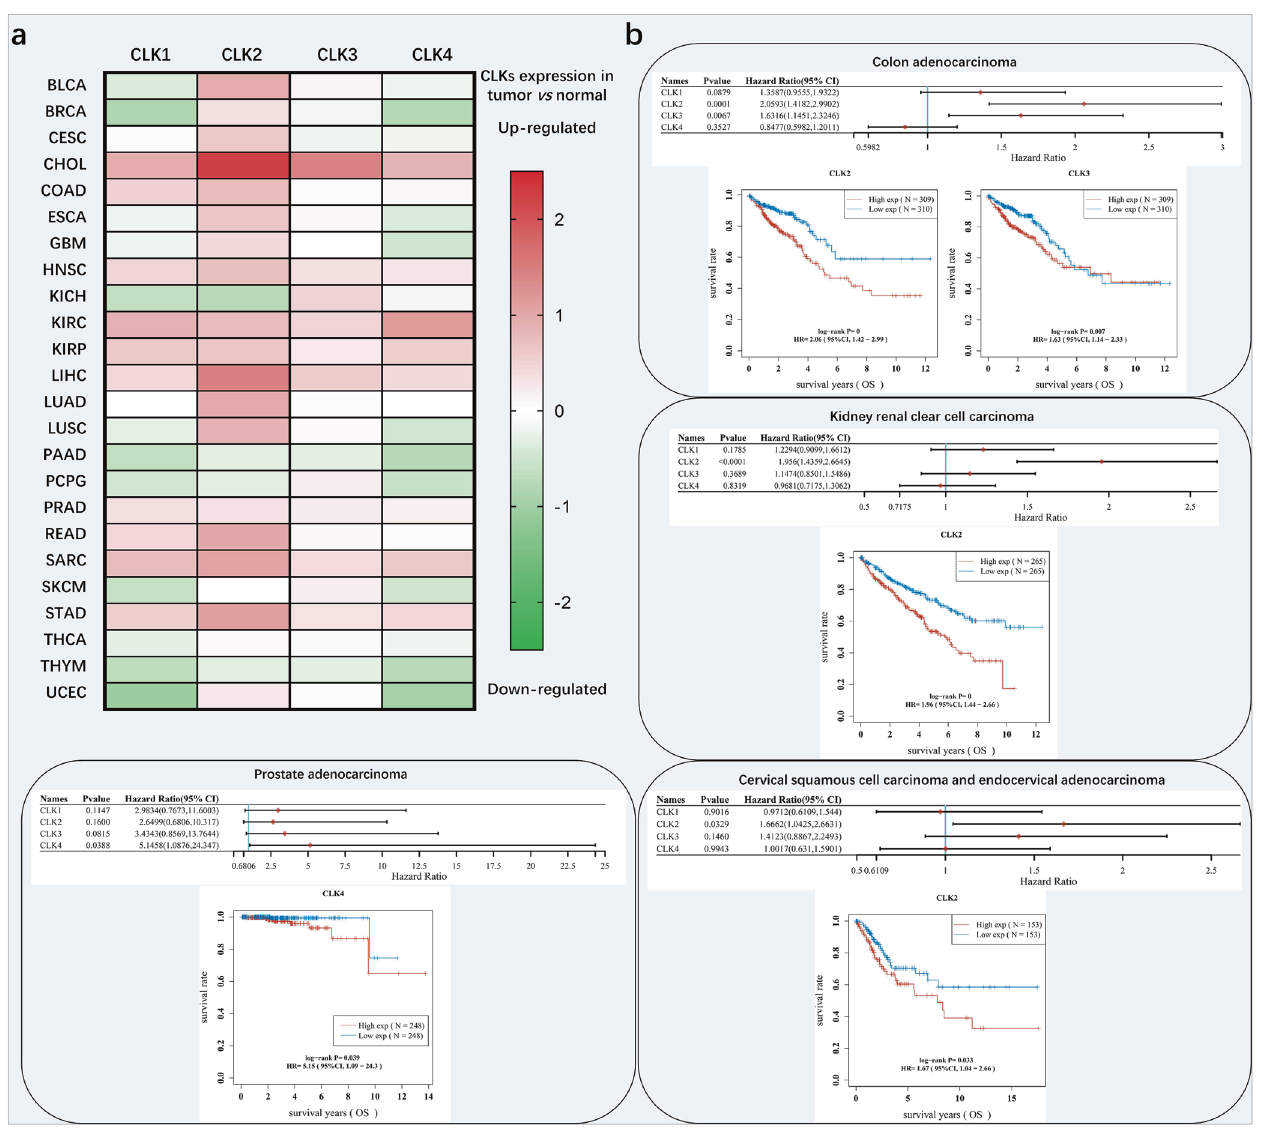
Fig. 5 Expression status and clinical outcomes associated with CLKs transcript levels in different tumor types. a RNA-seq data of CLKs expression in tumor and normal tissues were obtained from the TCGA database (https://portal.gdc.cancer.gov/). The Kruskal-Wallis test was used to assess statistical signi fi cance. b Raw counts of clinical survival information of CLKs were obtained from The TCGA dataset (https:// portal.gdc.cancer.gov/). The KM survival analysis with log-rank test was also used to compare the survival differences between the above two groups. For Kaplan – Meier curves, p values, and hazard ratio (HR) with 95% con fi dence interval (CI) were generated by log-rank tests and univariate Cox proportional hazards regression. *, ** and *** represented p < 0.05, p < 0.01 and p < 0.001, separately. p < 0.05 was